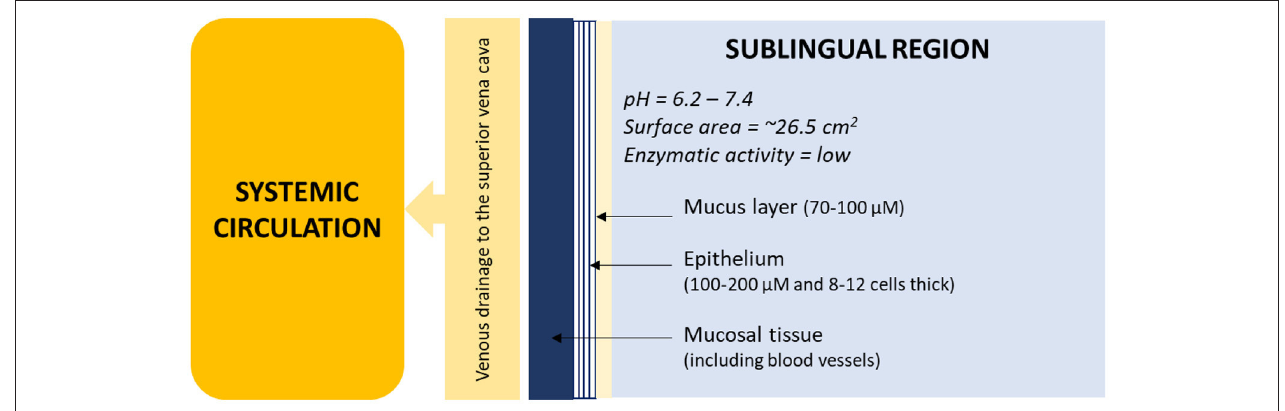
FIGURE 1 | Schematic diagram of the sublingual regions in the oral cavity. Data were originally presented in Hua